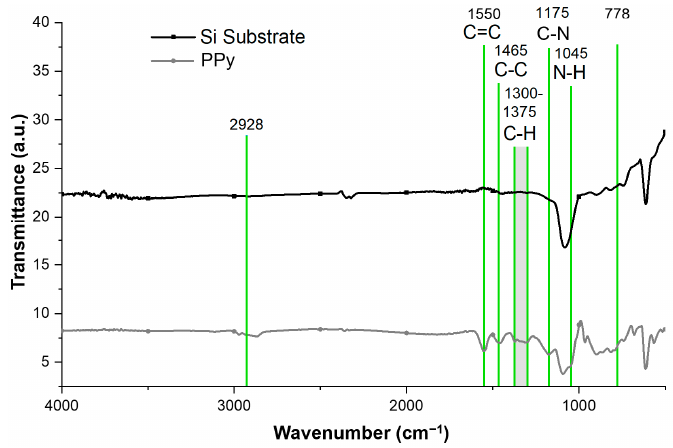
Figure 2. As grown vapor phase polymerized (VPP) Polypyrrole (PPy) FTIR spectra recorded in transmission mode and FTIR spectra of the silicon substrate reference.